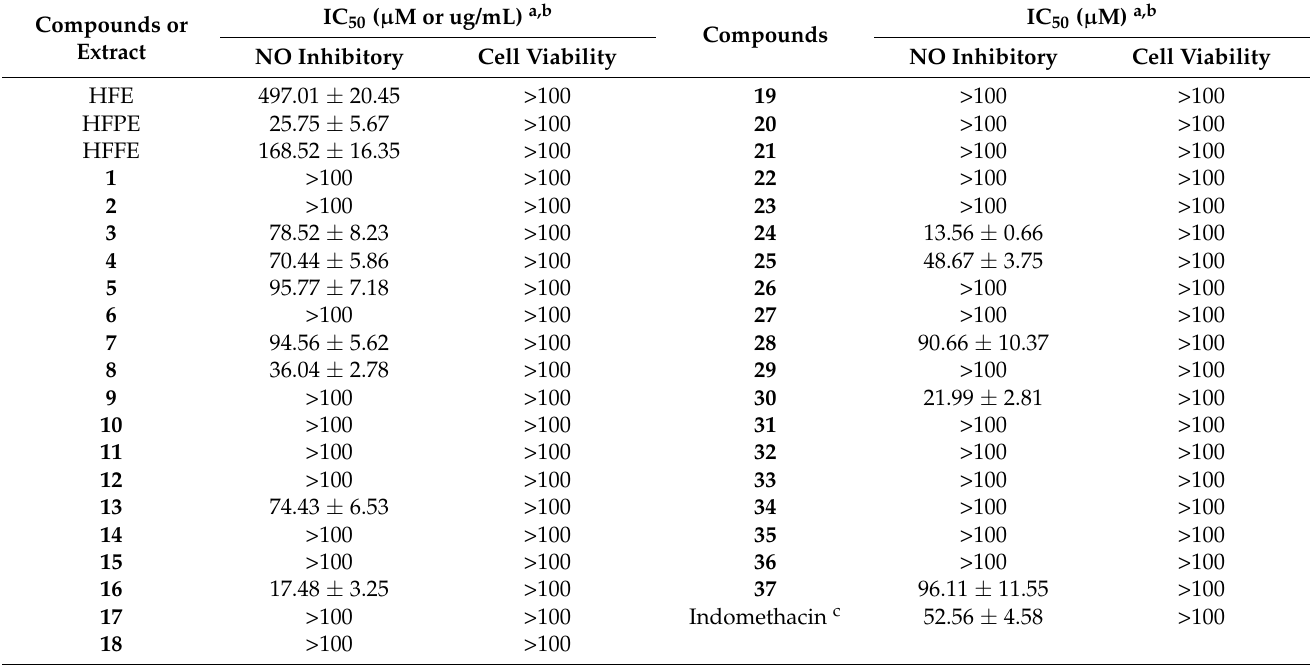
Table 2. Inhibitory effects on NO production induced by LPS in BV2 cells of the compounds or extract from H. citrina